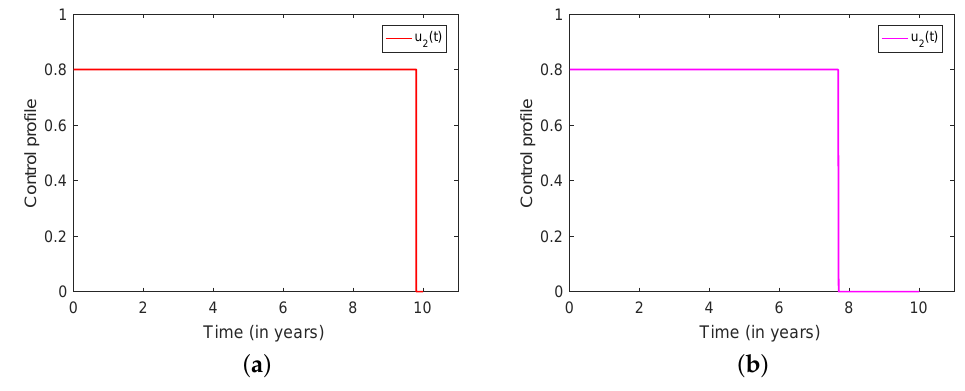
Figure 5. The control profile for Scenario 1: ( a ) low cost of culling; and ( b ) high cost of culling.